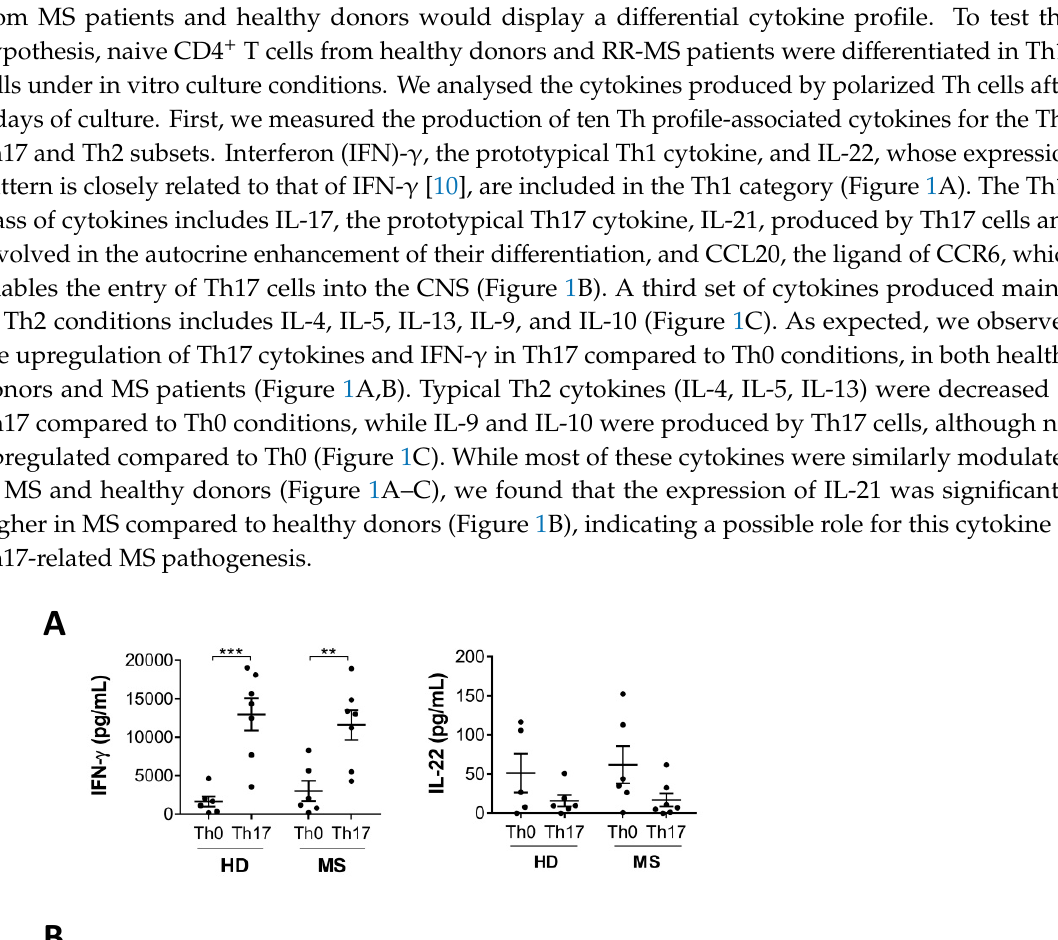
Figure 1. IL-21 production by Th17 cells is increased in MS patients compared to healthy donors. Naive CD4 T cells from healthy donors (HD) and multiple sclerosis (MS) patients were cultured with antiCD3-antiCD28 alone (Th0) or antiCD3-antiCD28 + TGF- β , IL-6, IL-23 and IL-1 β (Th17). At 5 days of differentiation the levels of typical cytokines of Th1 ( A ), Th17 ( B ), and Th2 ( C ) cells were analysed by multiplex assay (Luminex) in cell supernatants (* p < 0.05; ** p < 0.01; *** p < 0.001). 3.2. Production of Cytokines Involved in Inflammation and T Cell Activation are Increased in Th17 Cells from MS Patients To investigate other features related to Th17 cells, we analysed the production of additional inflammatory cytokines that are typically produced by activated lymphocytes, including TNF- α , IL- 8, and TNF- β , in Th17 cells differentiated from MS patients or healthy donors. We found that in MS patients, the production of TNF- α and β is significantly higher in Th0 and Th17 cells, respectively